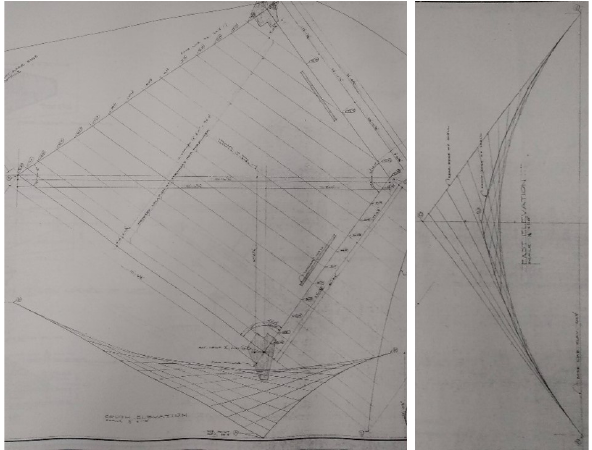
Figure 7: Shell form